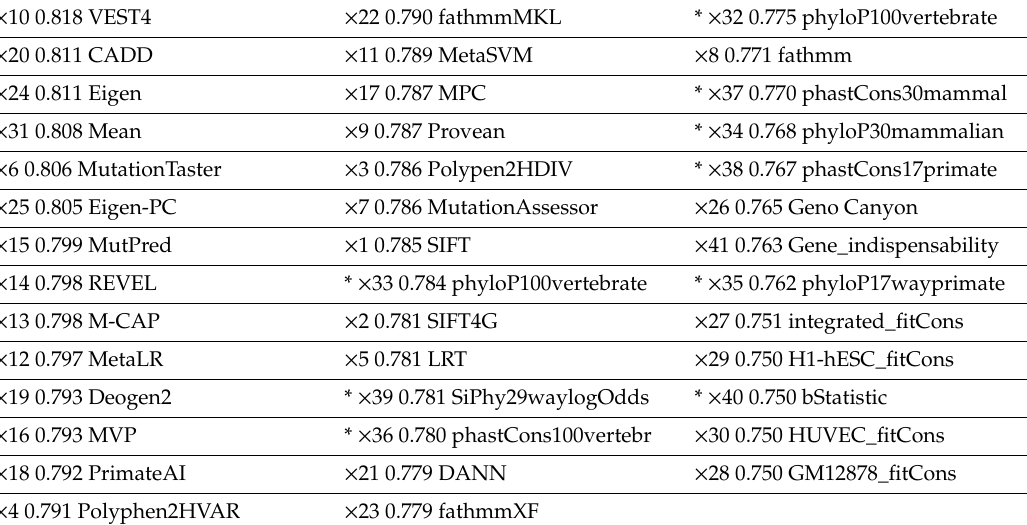
Table 2. Ranking of features sorted descending by pseudo- R 2 .